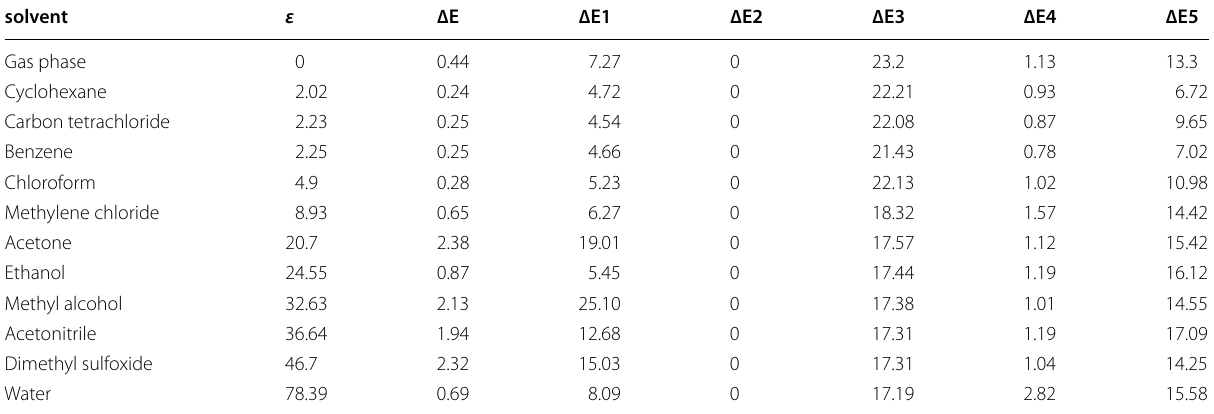
Table 3 Degradation reaction energy barrier for path A under different solvents unit: